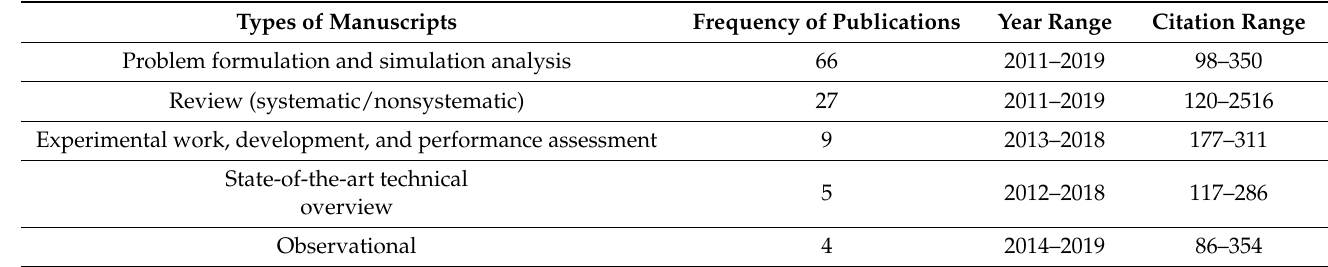
Table 2. Study types of the 110 highly cited manuscripts in the Scopus